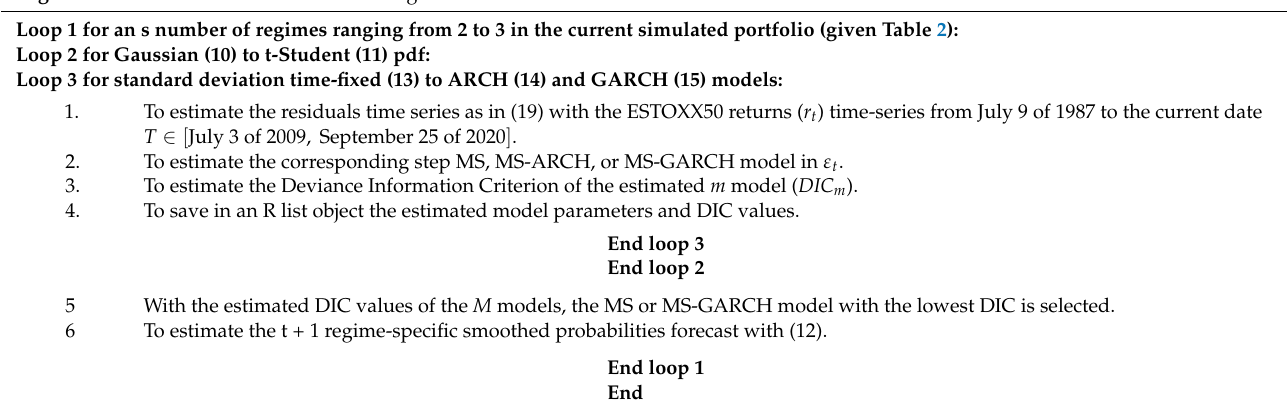
Algorithm 1 The estimation of the best-fitting MS or MS-GARCH